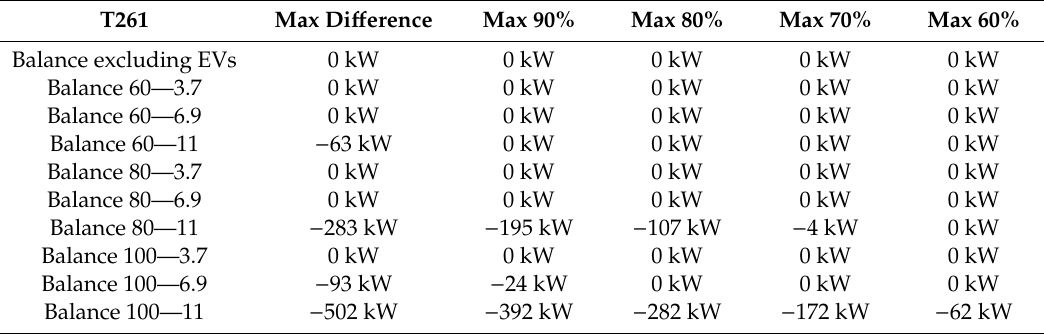
Table 10. Replacement of electric heating by district heating for transformer T261—late night charging.